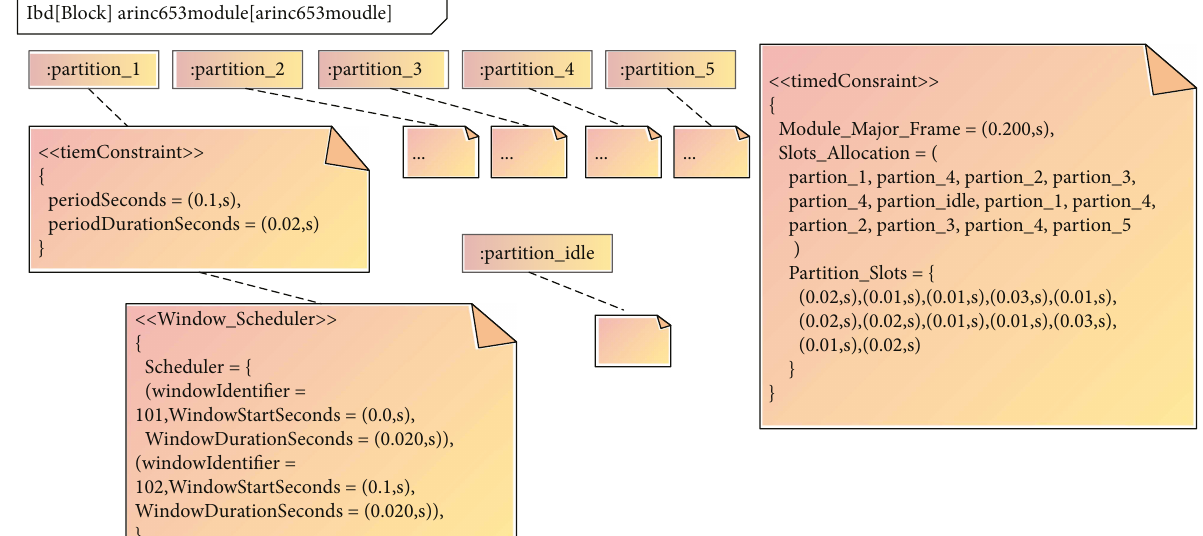
Figure 19: Partition con fi guration schedule model of MARTE.